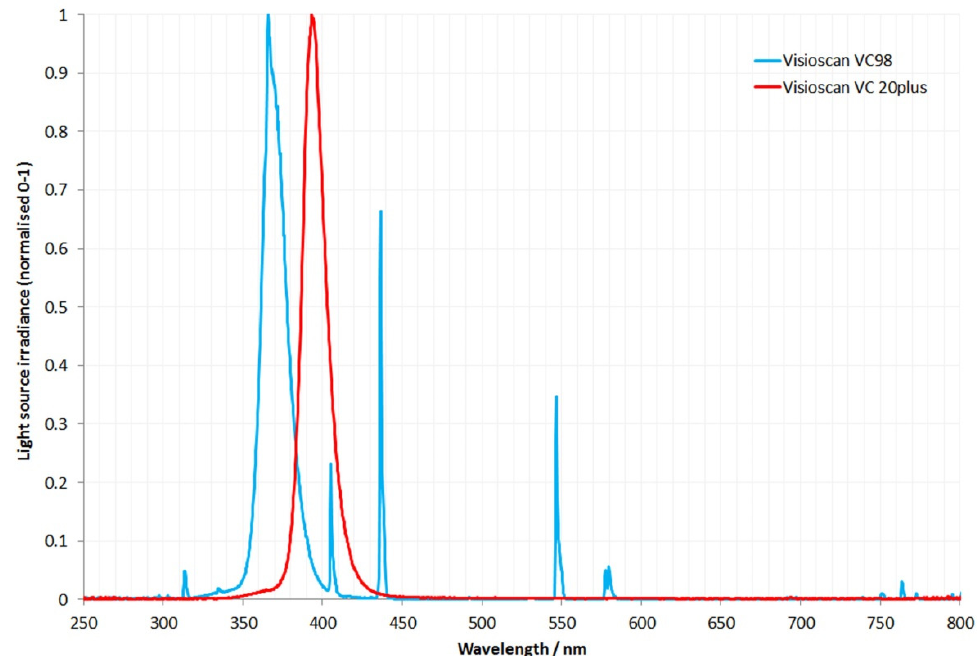
Figure 2. Irradiance spectra of the light sources used in the Visioscan ® VC98 and VC 20plus between 250 nm and 800 nm. Spectral intensity has been normalized to the maximum intensity for each light